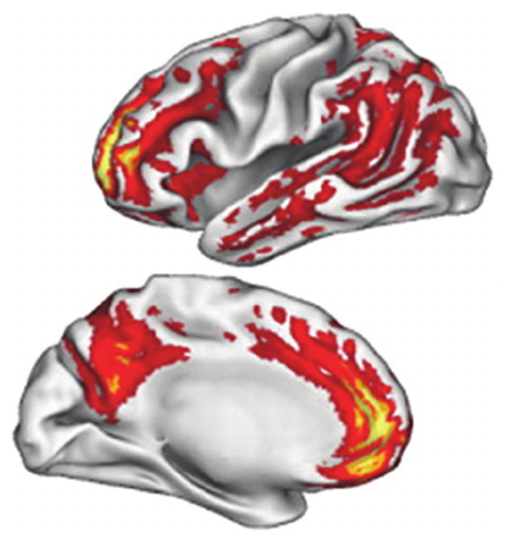
Figure 4: Surface maps indicating the pattern of [C-11]PIB binding obtained with 10 patients with clinical Alzheimer’s disease compared with 29 healthy older control subjects. Adapted and reprinted with permission from Buckner et al. [21] [Copyright (2005) Journal of